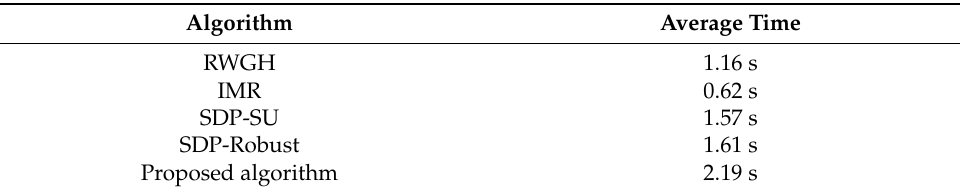
Figure 11. CDFs of the RMSE with σ = 20 m. ( a ) The CDF with one NLOS BS. ( b ) The CDF without NLOS BSs. Table 3. Training options for the DenseNet